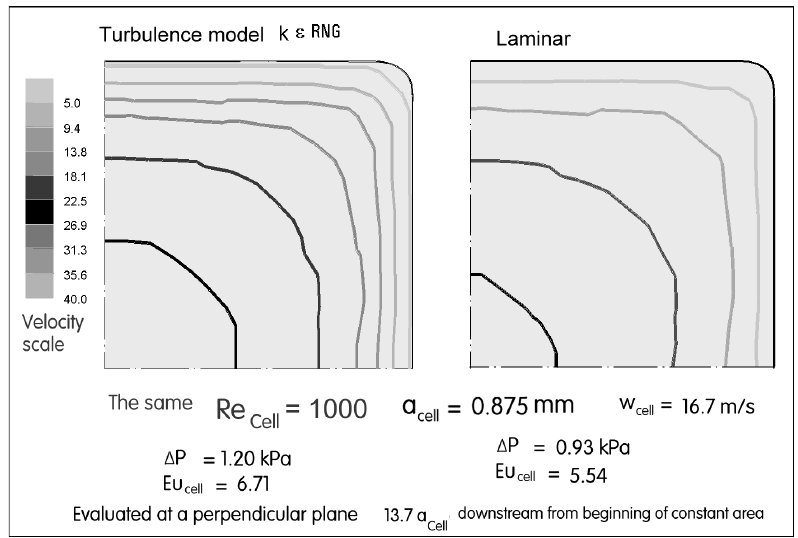
Figure 15. Comparison of computed isotach lines in the section across constant-area part of the passage obtained by computations under the same Reynolds number conditions with two flow models (laminar and low turbulence Re).